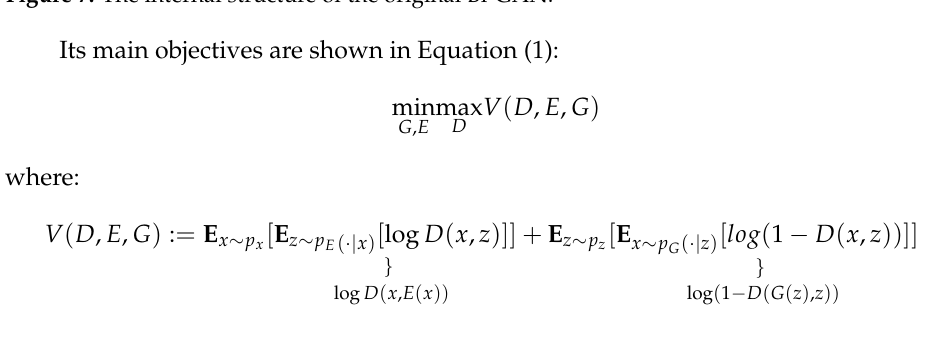
Figure 7. The internal structure of the original Bi-GAN.